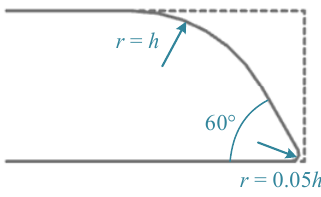
Figure 11. Schematic of trailing-edge trimming.